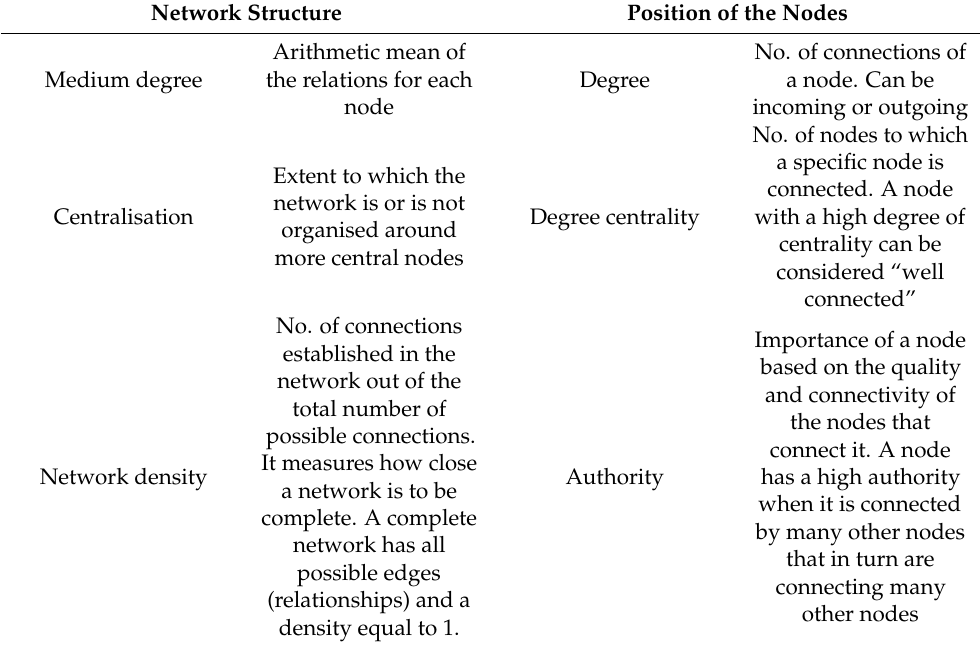
Table 1. Main statistics and indicators in the SNA.